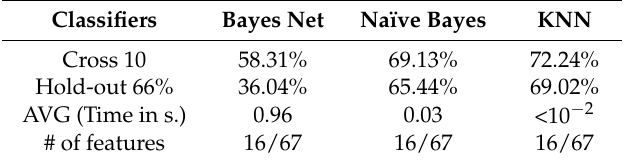
Table 4. Results using temporal features for Secure Password DB 150.